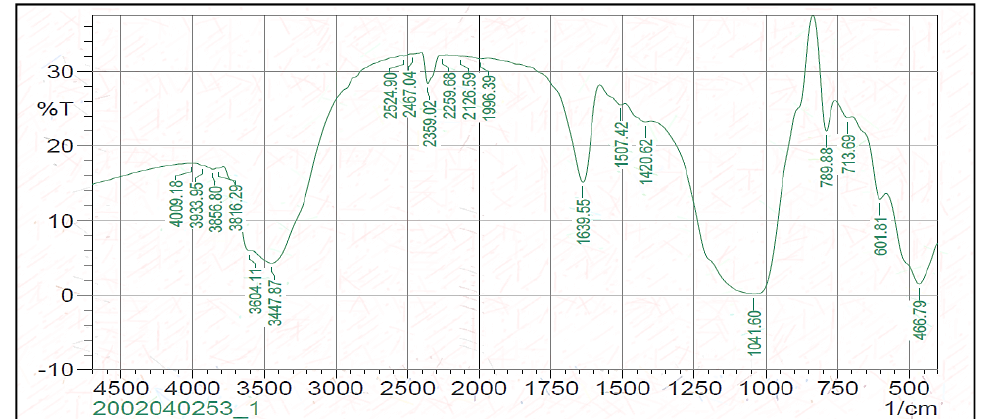
Figure 3. Fourier transform infrared spectroscopy (FTIR) spectra for the experimental nano-zeolite.